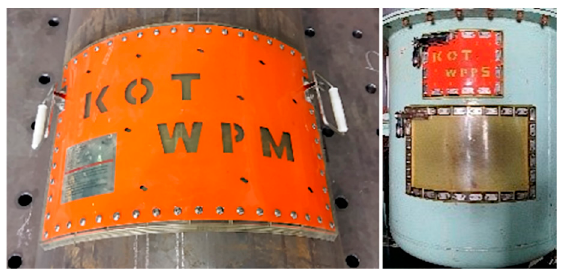
Figure 13. Round surface attachment test (left: 700 mm (pipe), right: 1000 mm (cylinder)).